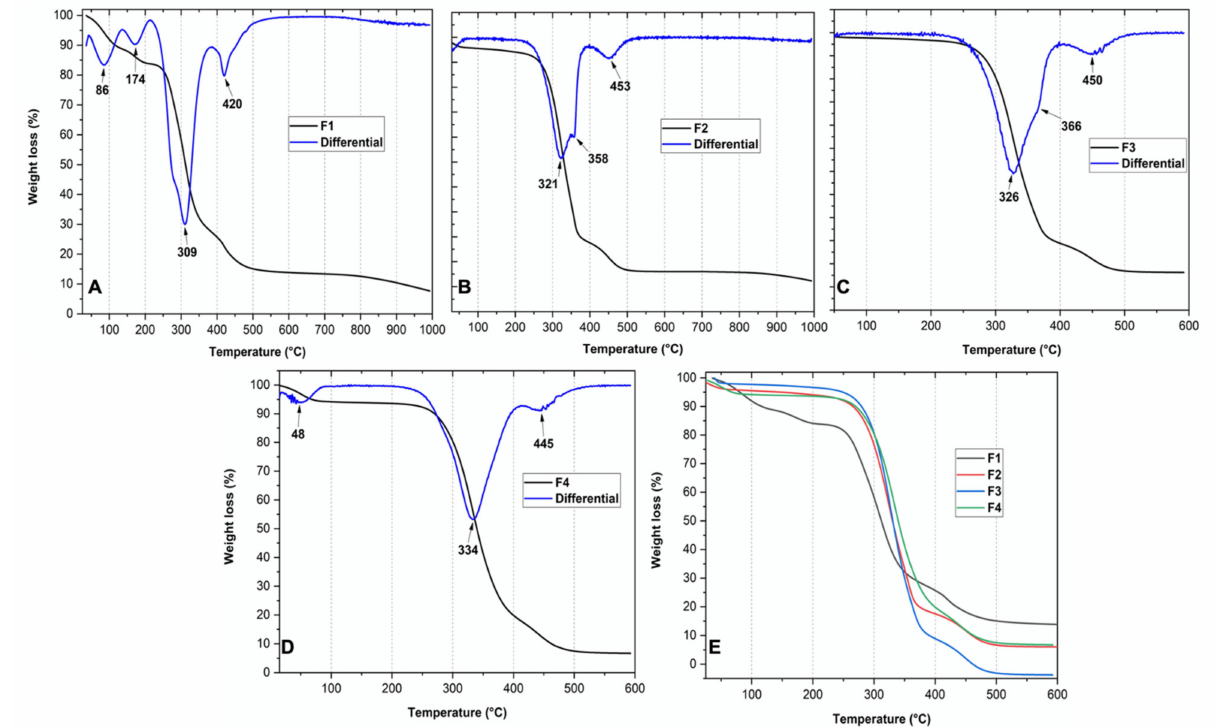
Figure 3. TGA curves of the nanofibers. Formulations: F1, ( A ) (CS:PVA:ox-CNO 8:92:0); F2, ( B ) (CS:PVA:ox-CNO 8:91:1); F3, ( C ) (CS:PVA:ox-CNO 3.5:95.5:1); F4, ( D ) (CS:PVA:ox-CNO 5.4:92.6:2); ( E ) all the